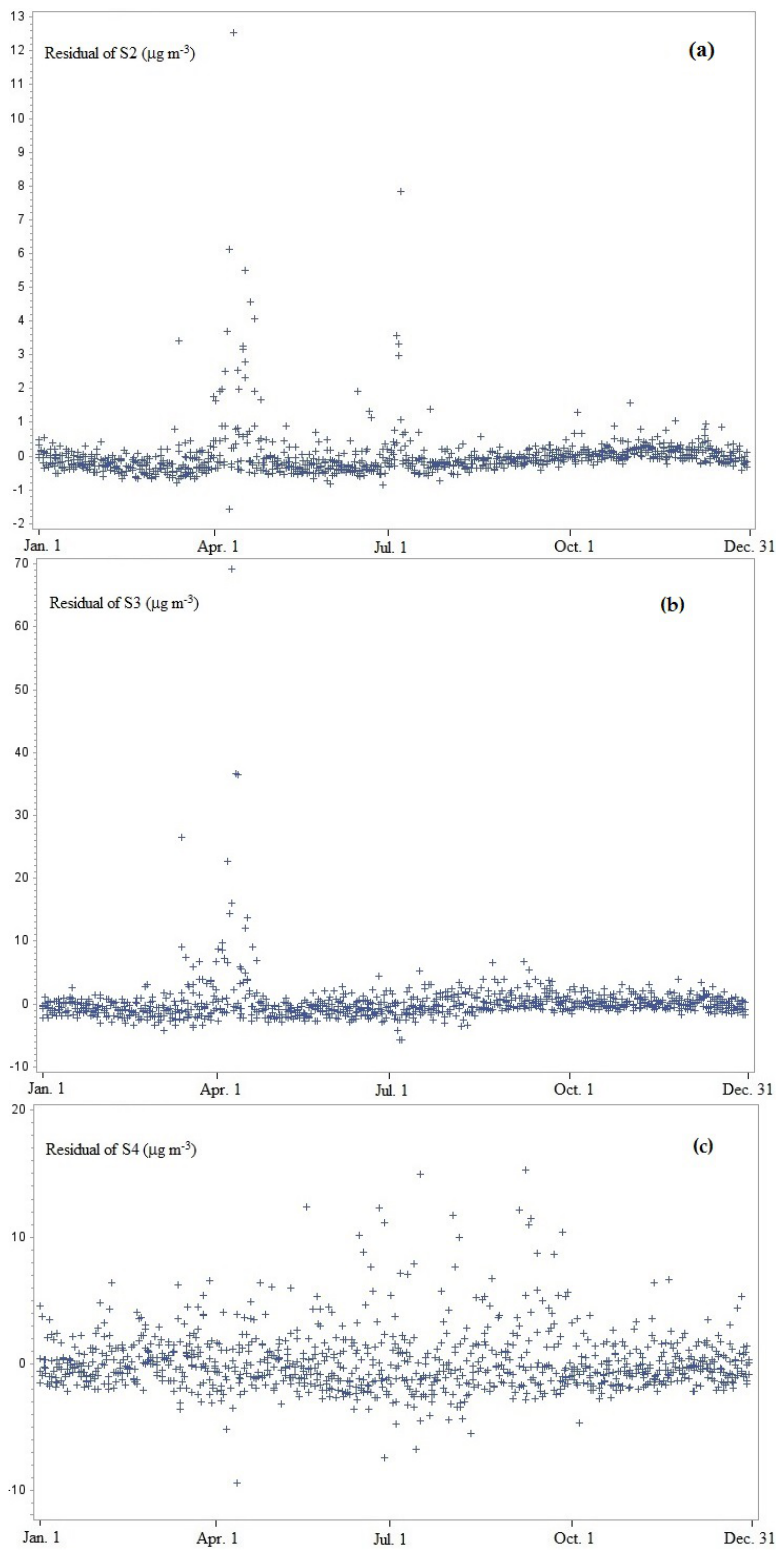
Figure 2. Effect of date on model residual of ( a ) S2—primary smoke particles; ( b ) S3—secondary organic aerosol; and ( c ) S4—sulfate/industrial.